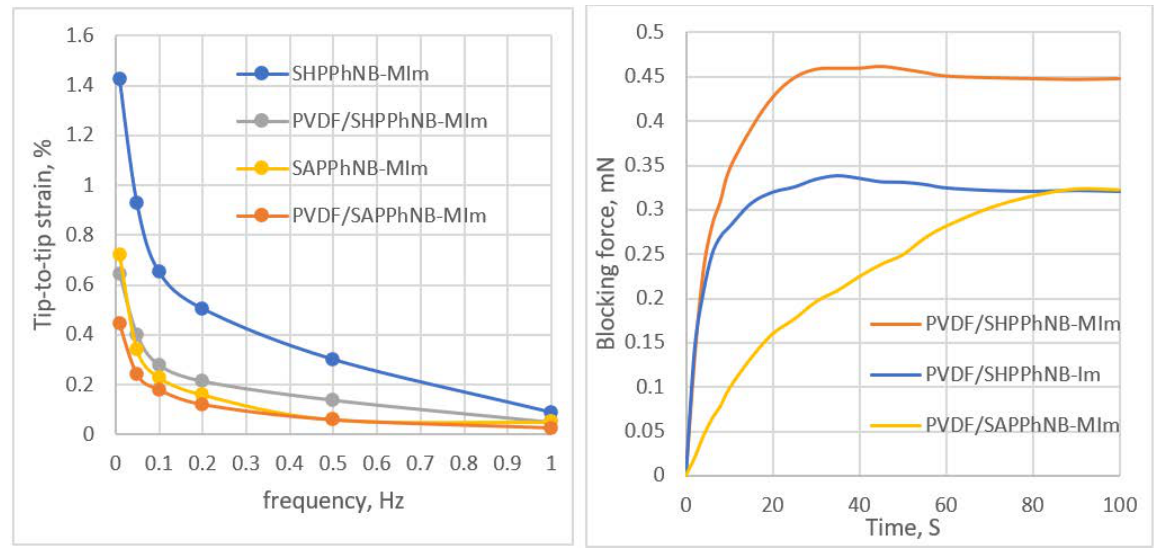
Figure 6. Strain calculated from the peak-to-peak displacements as the function of the frequency under voltage of 2 V of triangular waveform and the time dependence of generated blocking force under 2